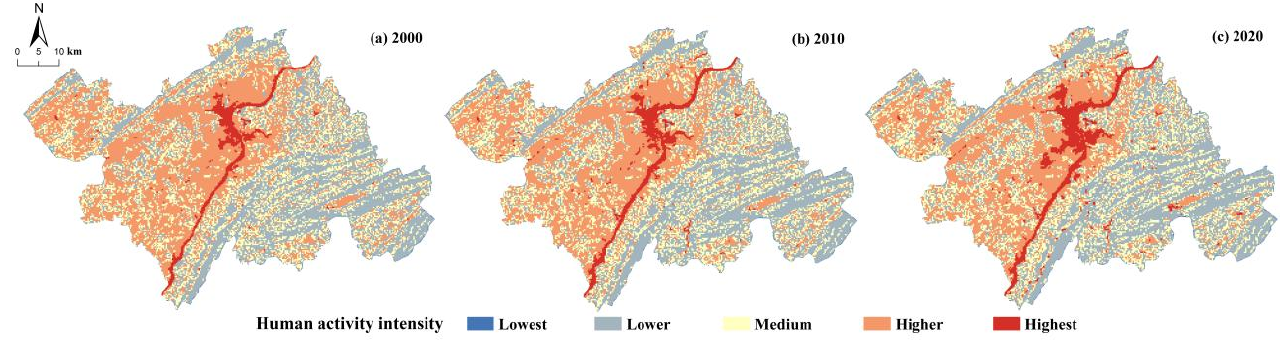
Figure 8. Degree of human activity intensity in 2000 ( a ), 2010 ( b ), and 2020 ( c ).